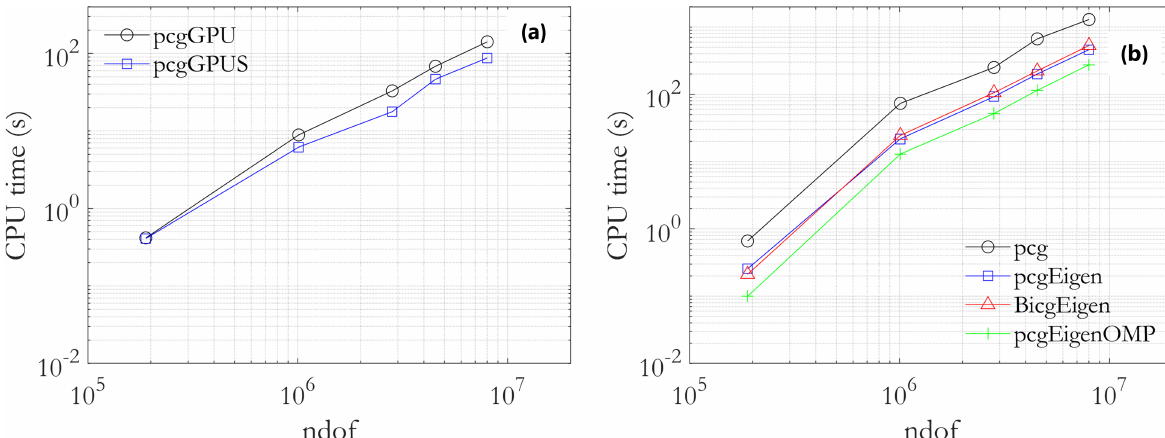
Figure 14. Comparison of the processing times of solvers (a) on the GPU and (b) on the CPU.